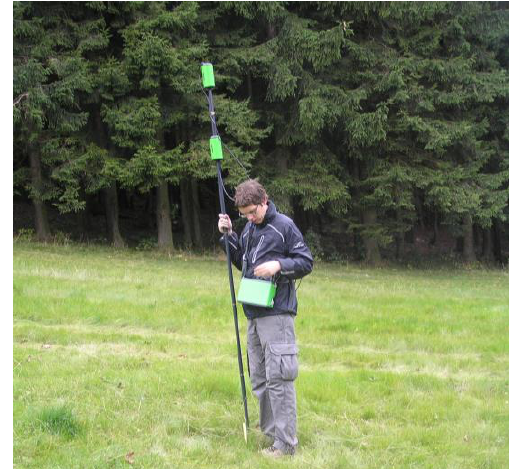
Figure 3. The gradient magnetometer in the field.